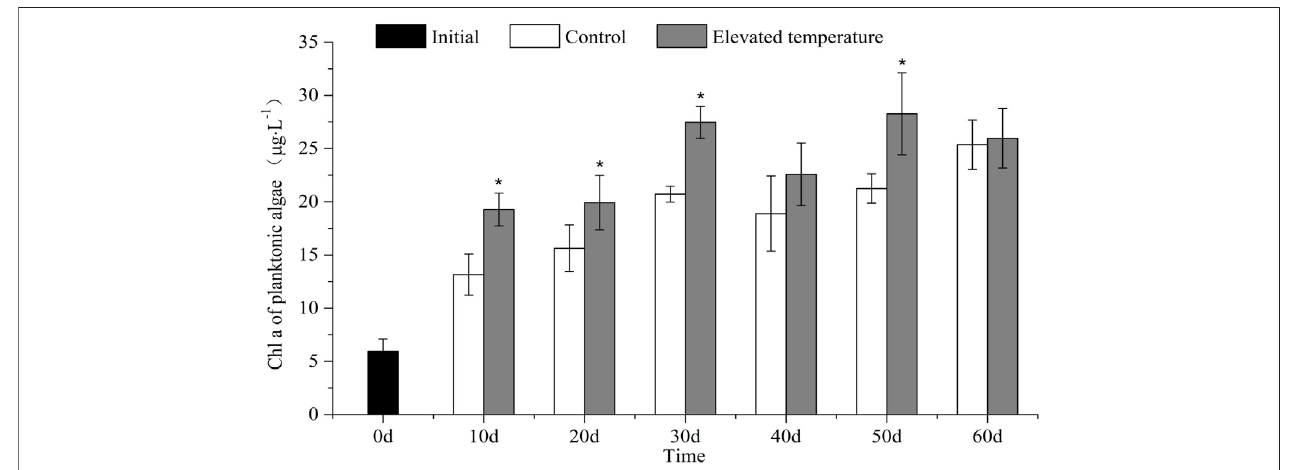
FIGURE 2 | Chl a of planktonic algae (mean ± SD) in different treatments over time. Asterisk indicates signi fi cant ( p < 0.05) differences between treatments.